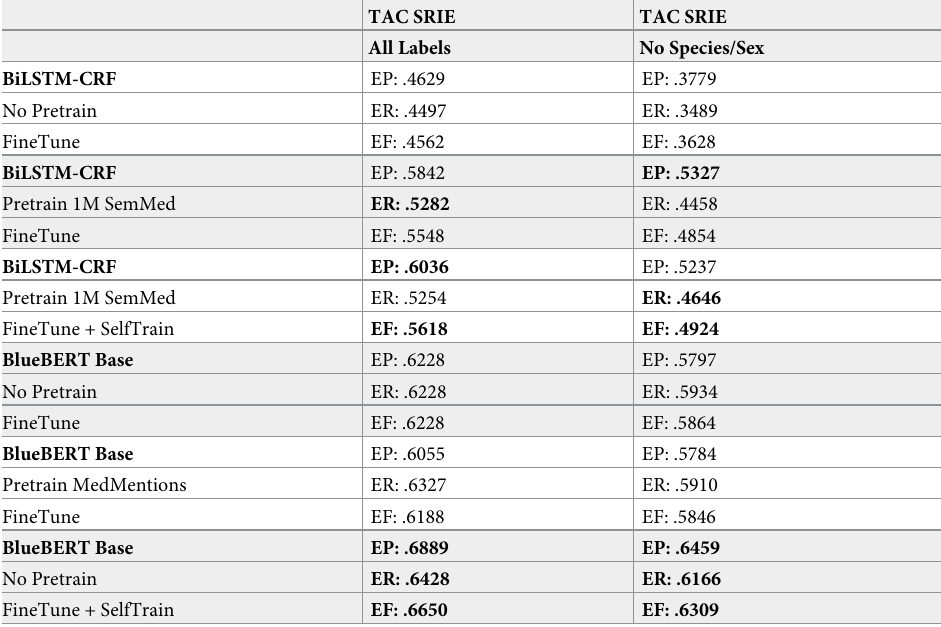
Table 8. Exact precision, recall, and F1 score of the BiLSTM-CRF and BlueBERT on the TAC SRIE datasets. We show the effect of including pre-training and including semi-supervised